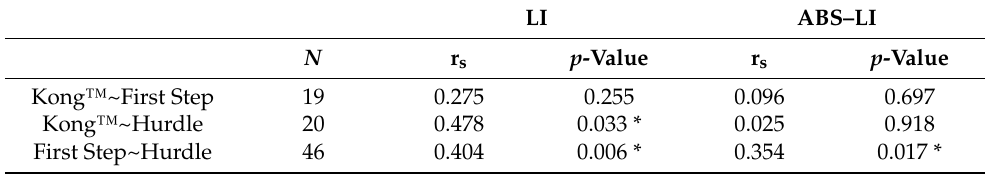
Table 2. Correlations of LI and ABS–LI scores between the different tests (i.e., Kong™ Test, pooled First Step and pooled Hurdle Test). Sample sizes ( N ), Spearman’s correlation coefficients (r s ), and Bonferroni-corrected p-values are shown (* p < 0.05).